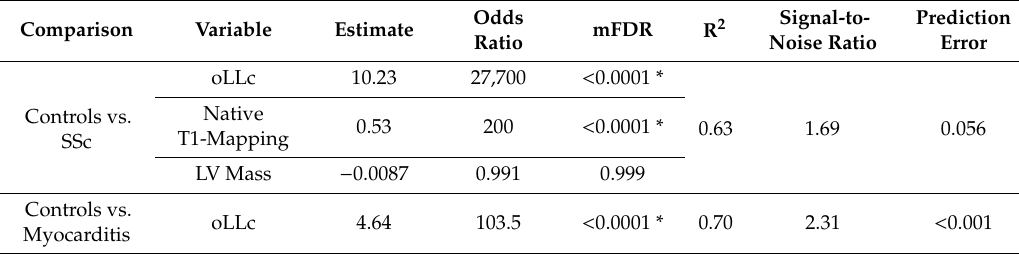
Table 4. Results of MCP logistic regression analysis for discriminating between controls and SSc / infectious myocarditis